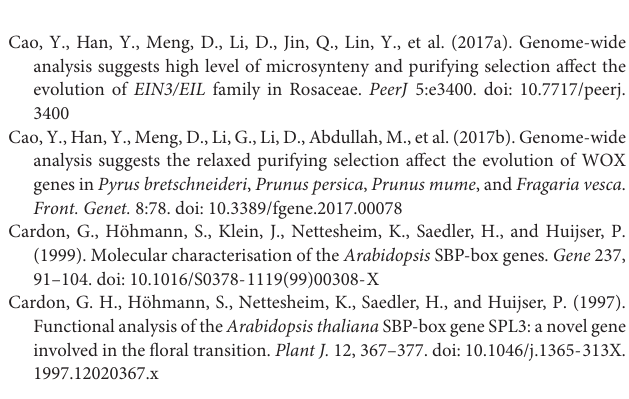
TABLE S1 | Synonymous and non-synonymous substitution rates for the duplication events in Rosaceae species. TABLE S2 | The detailed information of SBP-box genes from Strawberry, Pear, Peach, and Mei. TABLE S3 | cis -Acting element of 80 SBP protein sequence. TABLE S4 | Analysis of type I functional divergence. TABLE S5 | Analysis of type II functional